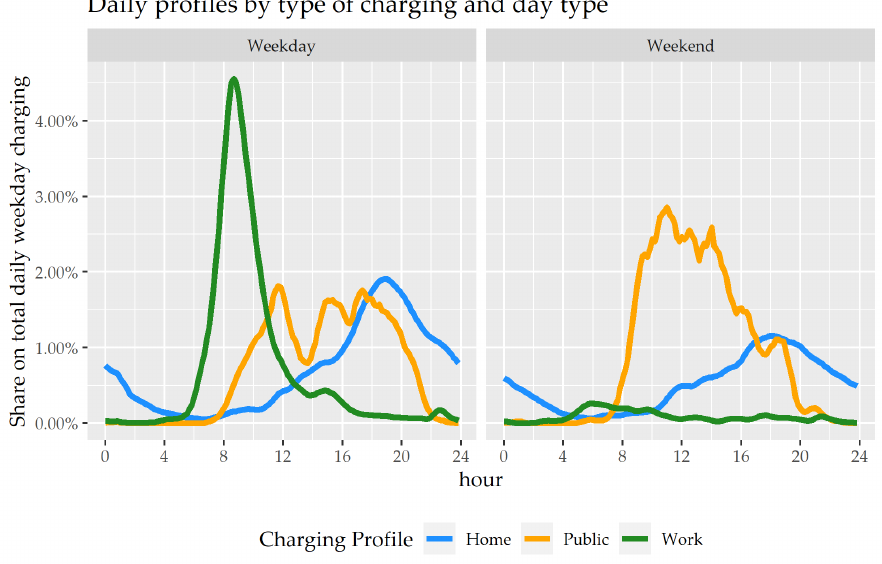
Figure 1. Different electric vehicle (EV) charging